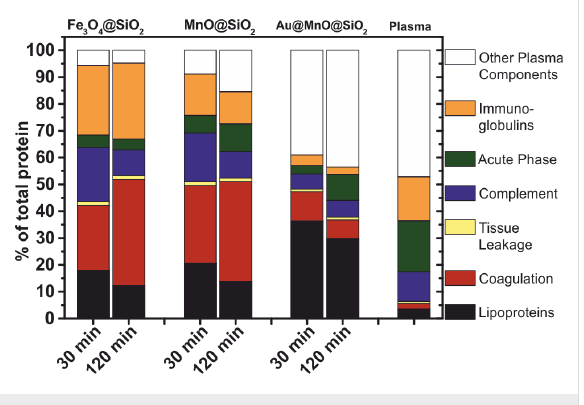
Figure 18: Labelfree LC-MS Analysis of the hard protein corona of Fe 3 O 4 @SiO 2 , MnO@SiO 2 , and Au@MnO@SiO 2 nanoparticles showing a dependence on composition, morphology, as well as incu- bation